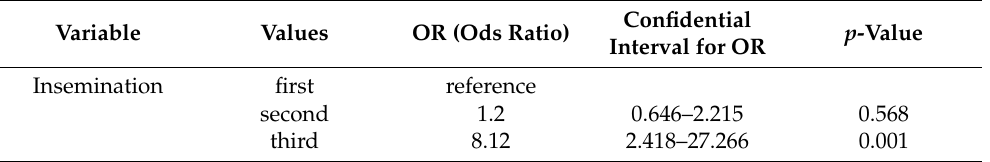
Table 3. Final model of the binary logistic regression. Dependent variable: fertility (kindling rate). The only predictable independent variable was the number of insemination ( p -value =